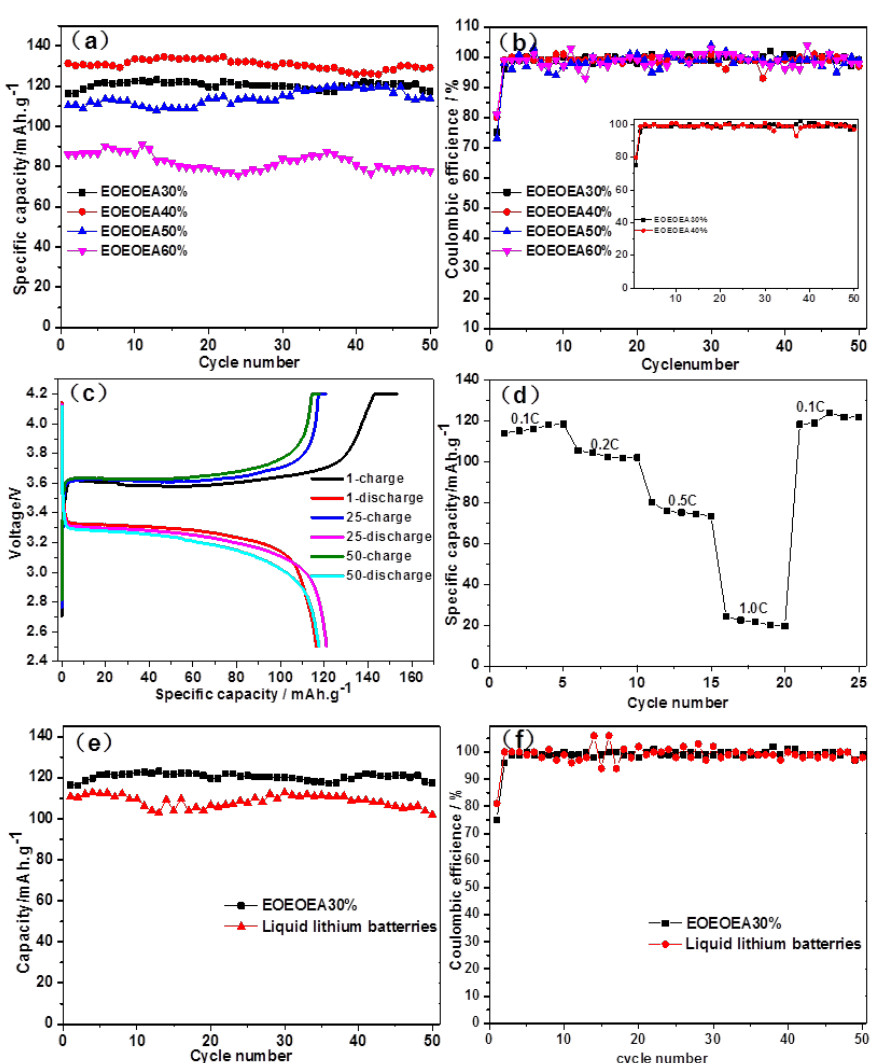
Figure 8. ( a ) Specific discharge capacities and ( b ) Coulomb efficiencies of different EOEOEA lithium batteries; ( c ) specific discharge capacities of the LiBF 4 -EOEOEA 30% lithium battery in the first, 25th, and 50th cycles; ( d ) discharging cycles of the LiBF 4 -EOEOEA 30% lithium battery at different rates; ( e ) specific discharge capacities and ( f ) Coulomb efficiencies of the LiBF 4 -EOEOEA 30% lithium battery and the liquid LiBF 4 lithium battery.